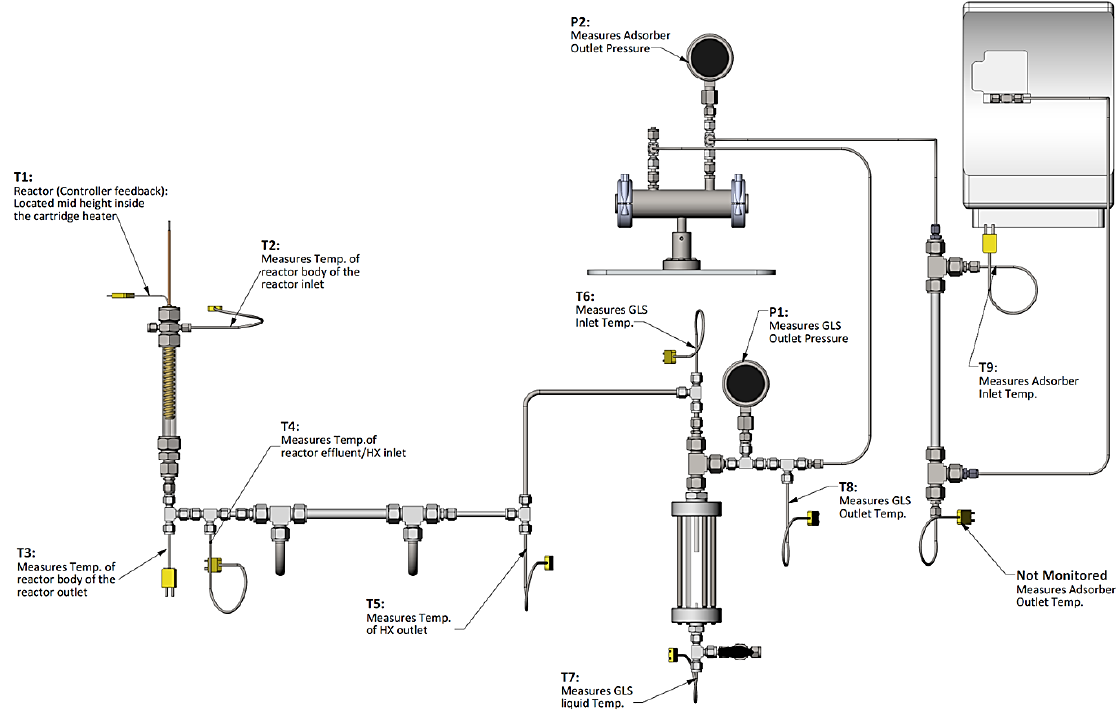
Figure 9. Reactor test bed apparatus equipped with reactor, heat exchanger, gas–liquid separator (GLS), impurity adsorbent bed, and gas-phase analytical components. Note: T denotes thermocouple, and P denotes pressure gauge.